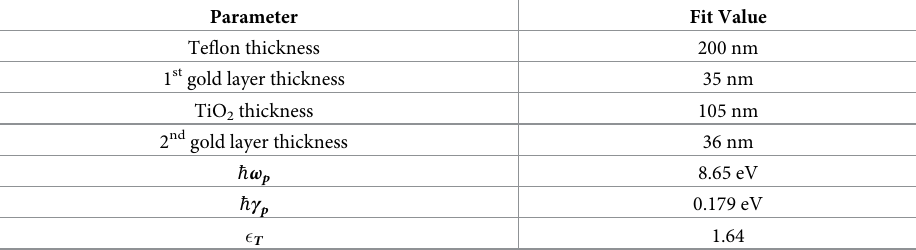
Table 1. Fitting parameters and the values obtained from fitting the ATR scans shown in Fig 5.